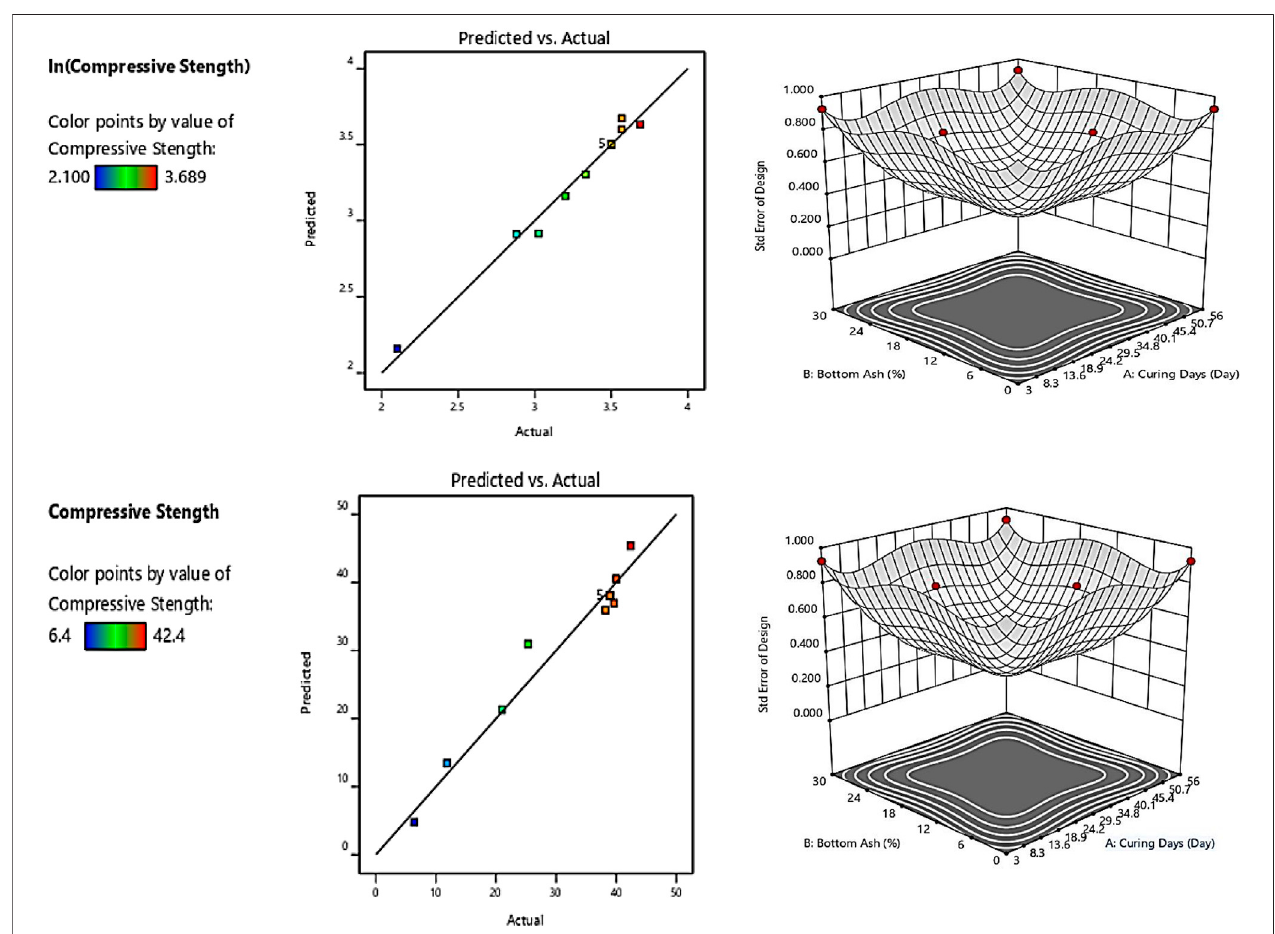
FIGURE 10 | Predicted vs. actual values ’ plot and standard error designs for compressive